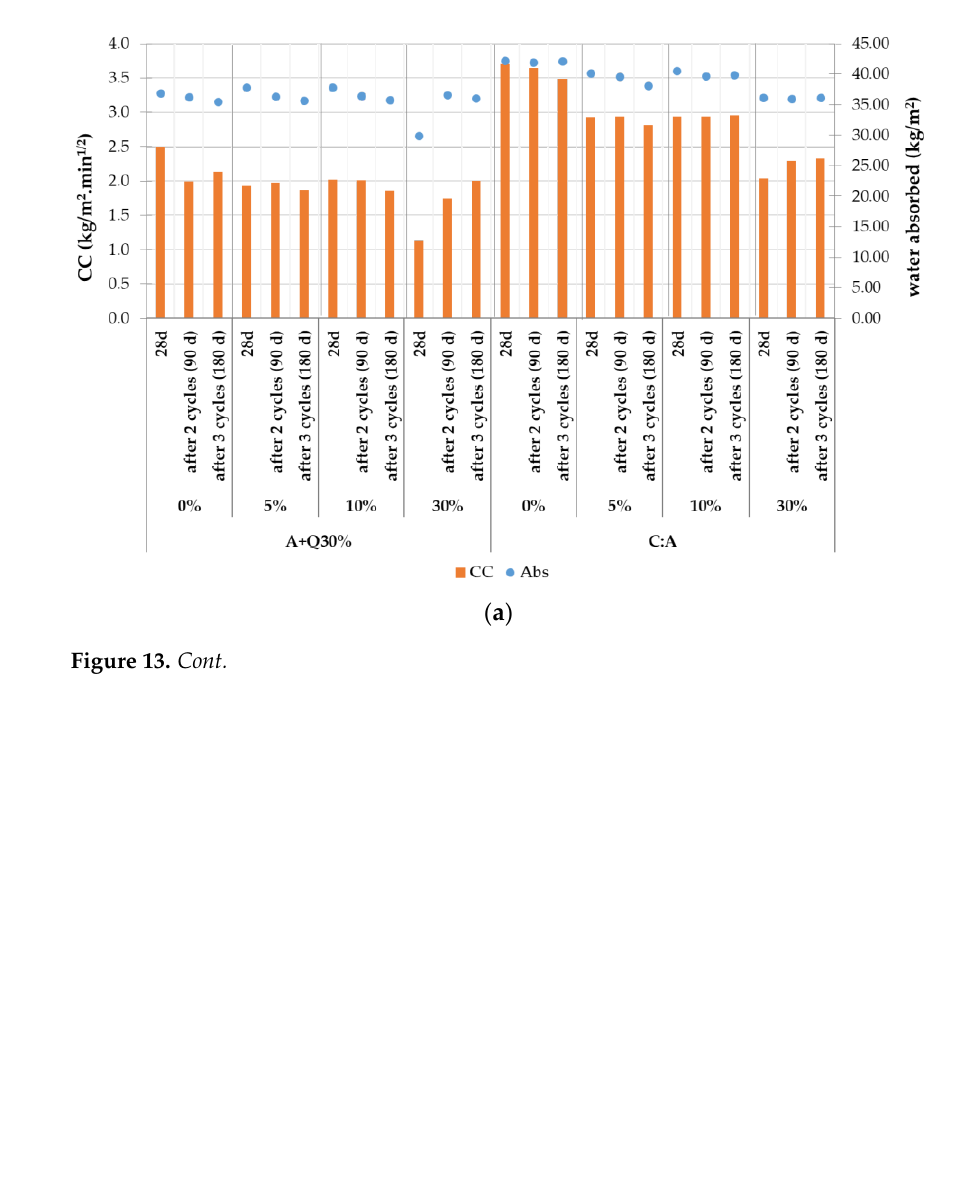
Figure 12. SEM image at high magnification (MAG: 10,000x), with a working distance (WD) of 15.4 mm, at A mortar surface where it is possible to observe the presence of different calcium carbonate crystals, some with an acicular shape attributed to phenomena of dissolution and reprecipitation of the carbonated binder.